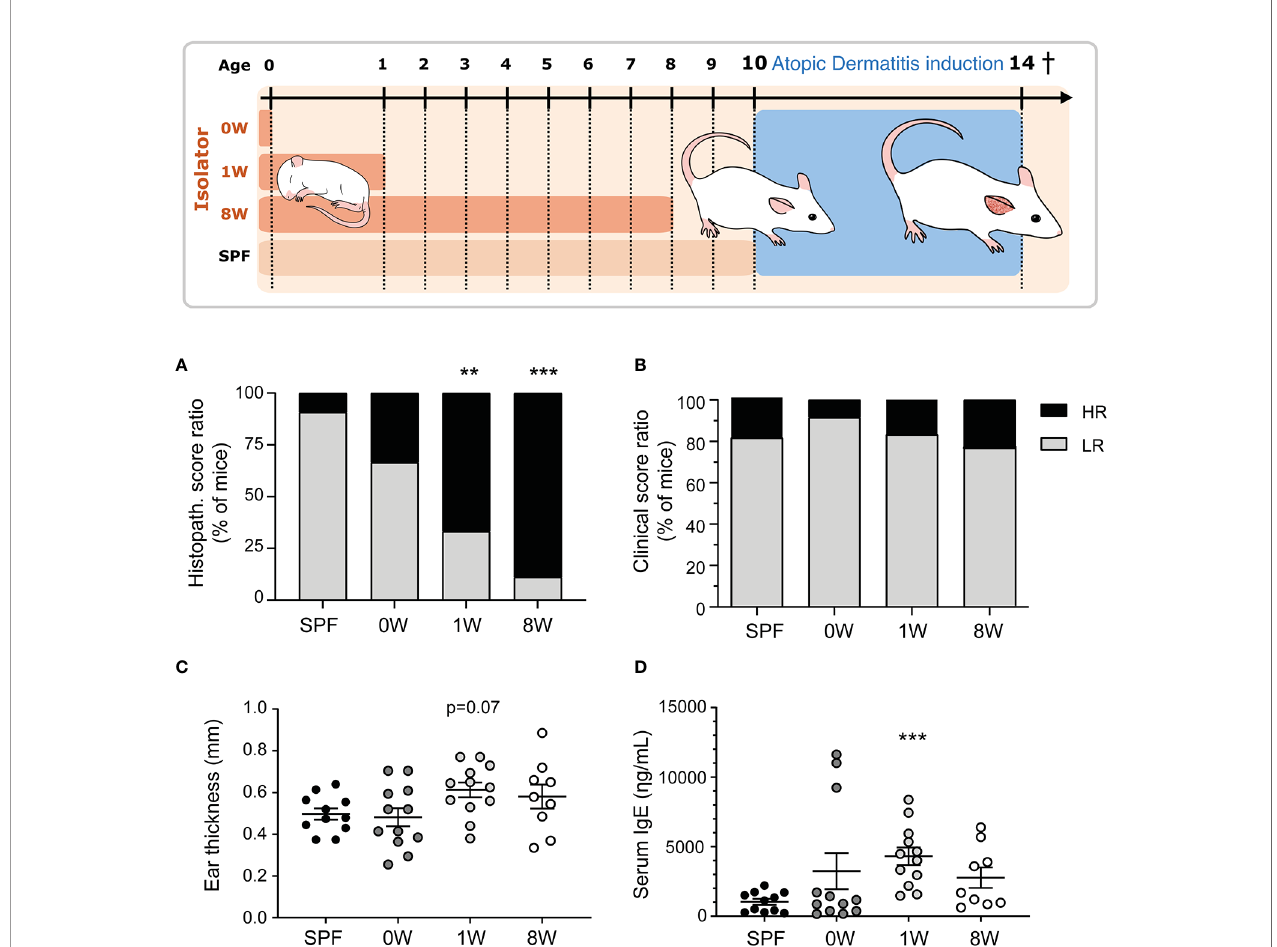
FIGURE 1 | Sensitivity to oxazolone-induced dermatitis in SPF and ex-germ-free mice. The experimental setup is outlined with three germ-free groups colonized at birth (0W, n =12), 1 week-of-age (1W, n =12), or 8 week-of-age (8W, n =9) and one microbiota-associated SPF bred control group (SPF, n =11). After 10 weeks-of- age, the mice were sensitized with 0.8% oxazolone before they were challenged ten times with 0.2% oxazolone solution on the right ear. The mice were euthanized at 14 weeks of age after the last challenge and sampled for further analyses. (A) HE stained cross sections of the in fl amed ears were scored blindly in all mice. The percentages of mice expressing a high (total score >8.5) or low (total score ≤ 8.5) responding phenotype are shown. (B) The degree of oxazolone-induced dermatitis was clinically scored by two blinded persons independently in all mice when euthanized. The percentages of mice expressing a high (average total score >7.5) and low (average total score ≤ 7.5) phenotype are shown. (C) Ear thickness was measured twice on anaesthetized mice immediately before euthanization. Mean and SEM are shown. (D) Serum IgE was measured with ELISA in all mice. Mean and SEM are shown. ** indicate p < 0.01, *** indicate p < 0.001. All p -values below 0.1 are